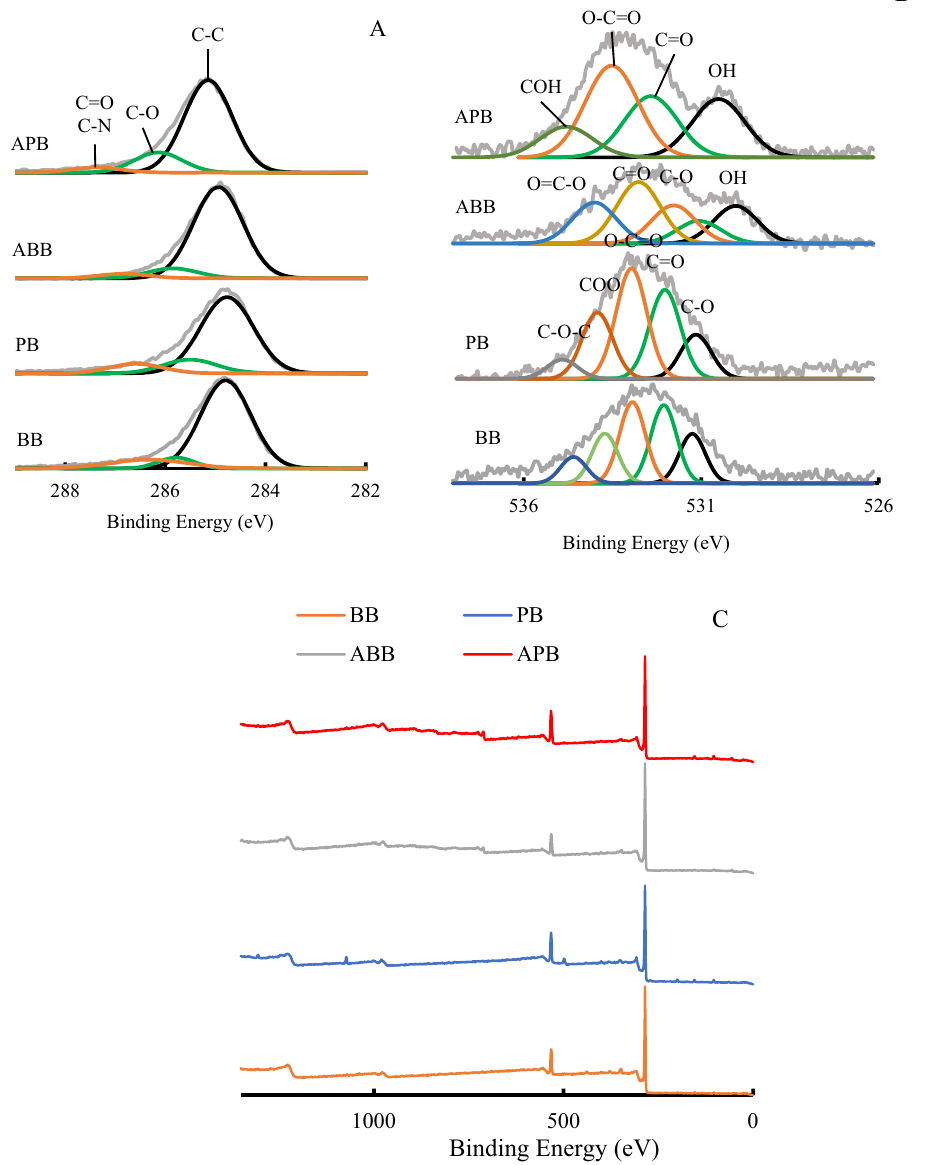
Figure 2. Peak fits of C1 s ( A ), O1 s ( B ) and maps ( C ) from different